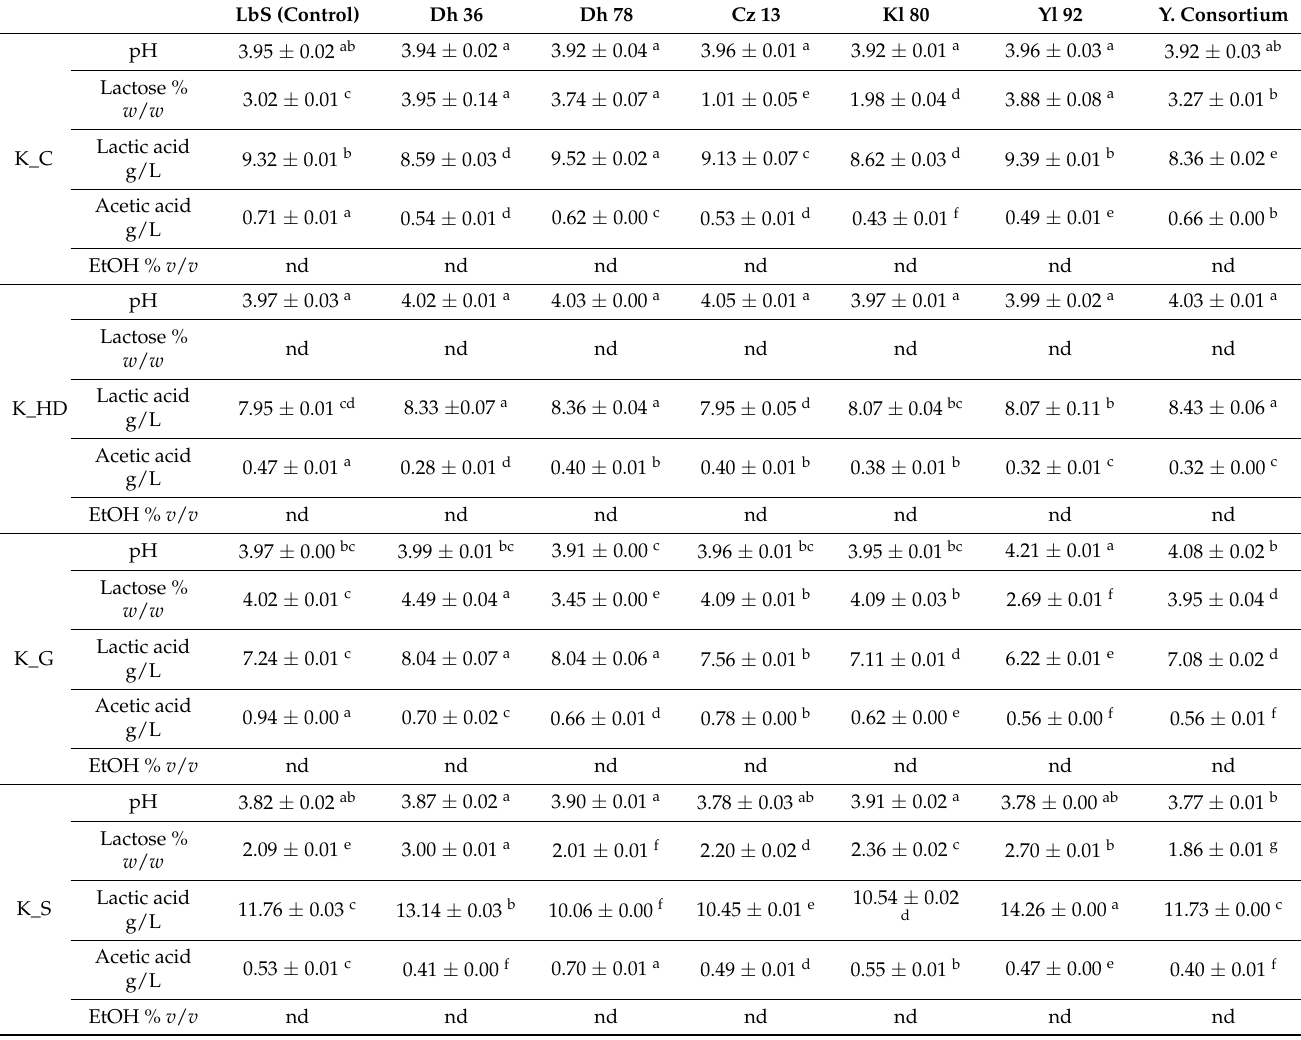
Table 2. Main analytical characters of kefirs from cow’s milk (K_C), lactose-free cow’s milk (K_HD), goat’s (K_G), and sheep’s (K_S) milk obtained by LbS and yeast fermentation, at the end of the storage period (5 weeks). Data means ± standard deviations and values showing different superscript letters ( a,b,c,d,e,f,g ) within each line are significantly different according to Duncan tests ( p <